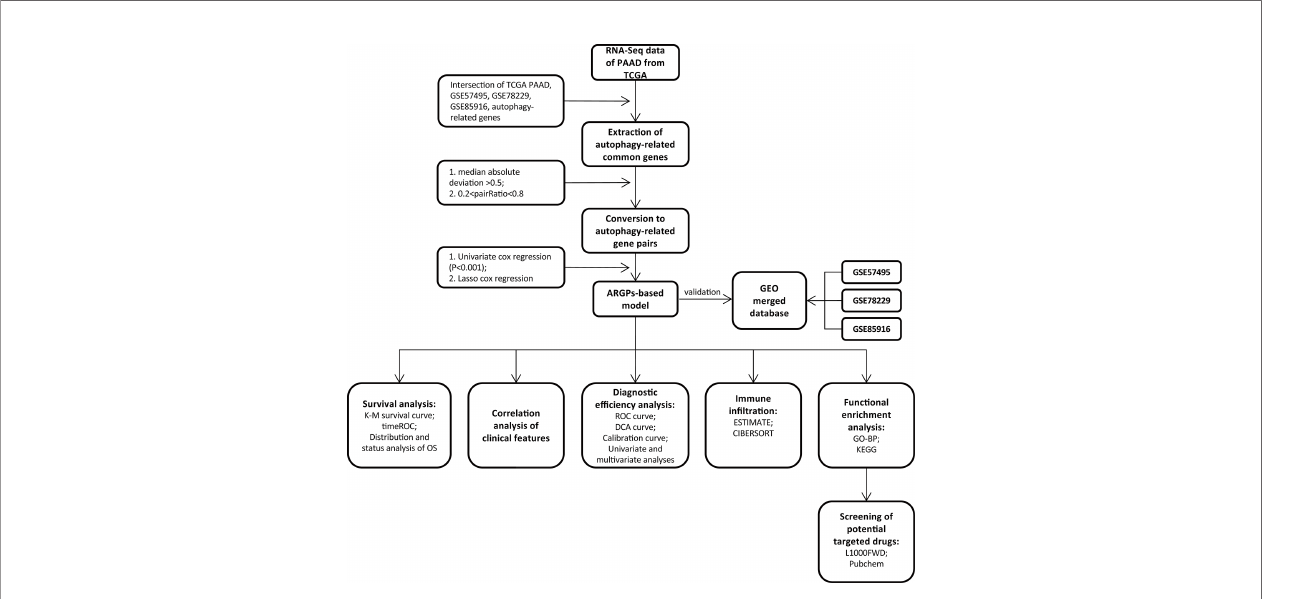
FIGURE 1 | Flow chart of the overall study design.